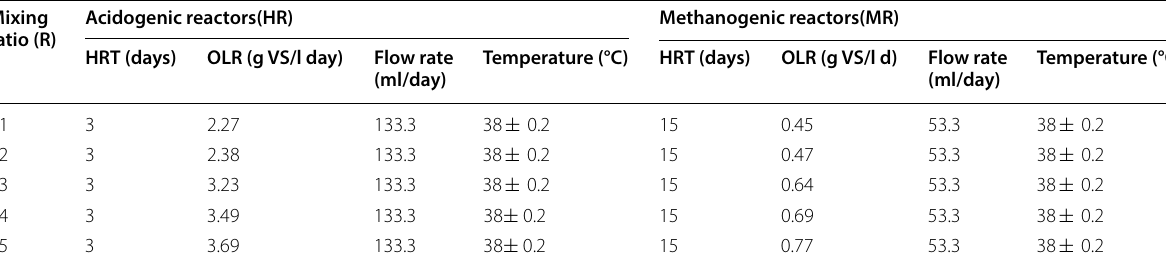
Table 4 Operating conditions and parameters during AD Mixing ratio